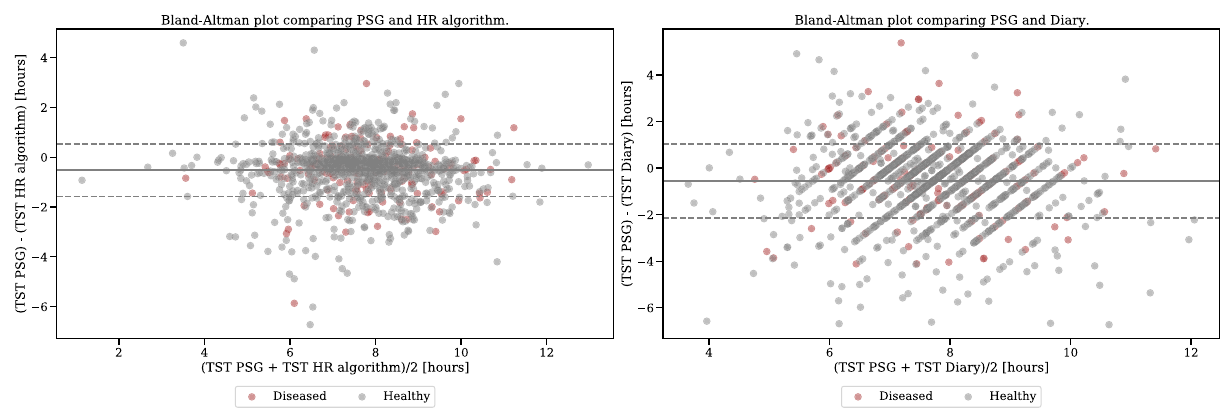
Figure 6. Modified Bland-Altman plot for MESA. Modified Bland-Altman plot on the left shows the TST differences (delta) between the HR algorithm and PSG in the Y-axis and the X-axis shows the TST average for every participant. The figure to the right shows the same comparison for the sleep diaries and PSG in MESA. Further, healthy participants are color coded in blue for both plots and participants that were diagnosed with sleep disorders are shown in